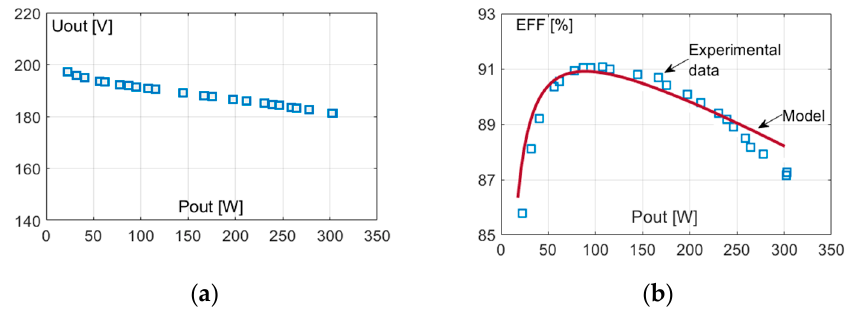
Figure 16. Experimental and simulation results for LSSCVMb under strategy C5 at U in = 50 V, f S = 133 kHz: ( a ) Measured output voltage U out vs. P out , ( b ) measured efficiency vs. P out with comparison to theoretical results obtained from (34) for r = 380 m Ω , V F = 400 mV, V CE(on) = 1 V, W sw = 11 μ J.